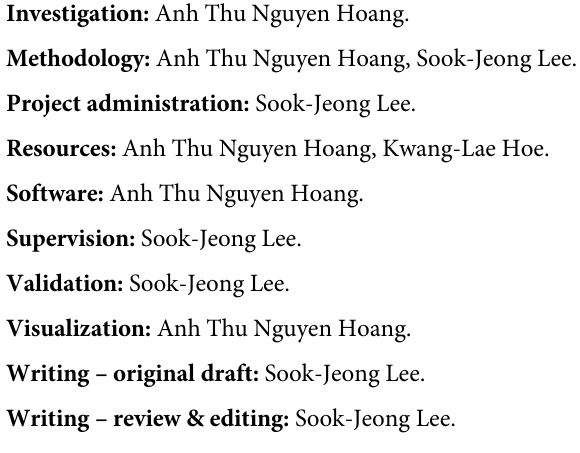
S3 Fig. mRNA expression of CSNK1G subtypes following CSNK1G2 silencing in ER + and ER - breast cancer cells. Quantitative analysis of mRNA expression in NC siRNA- or CSNK1G2 siRNA-transfected (A, B) MCF-7 cells and (C, D) MDA-MB-231. CSNK1G1 (A, C) and CSNK1G3 (B, D) expression levels were determined 24 h after 1 μ M TAM treatment. GAPDH was used as a loading control. Data are expressed as mean (SD); n = 4; � P < 0.05, �� P < 0.01, # P < 0.001 vs . each represented counterpart. S1 Table. Real-Time PCR primer